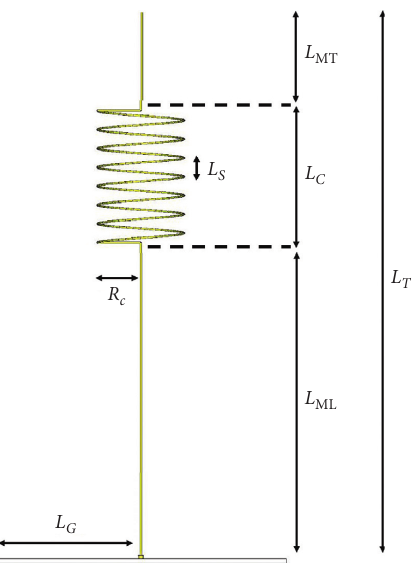
Figure 15: Side view of proposed loaded monopole antenna � 37, L � 11, L � 7, L � 1, L � 5, R � 2). ( L T � 55, L C S G C ML MT